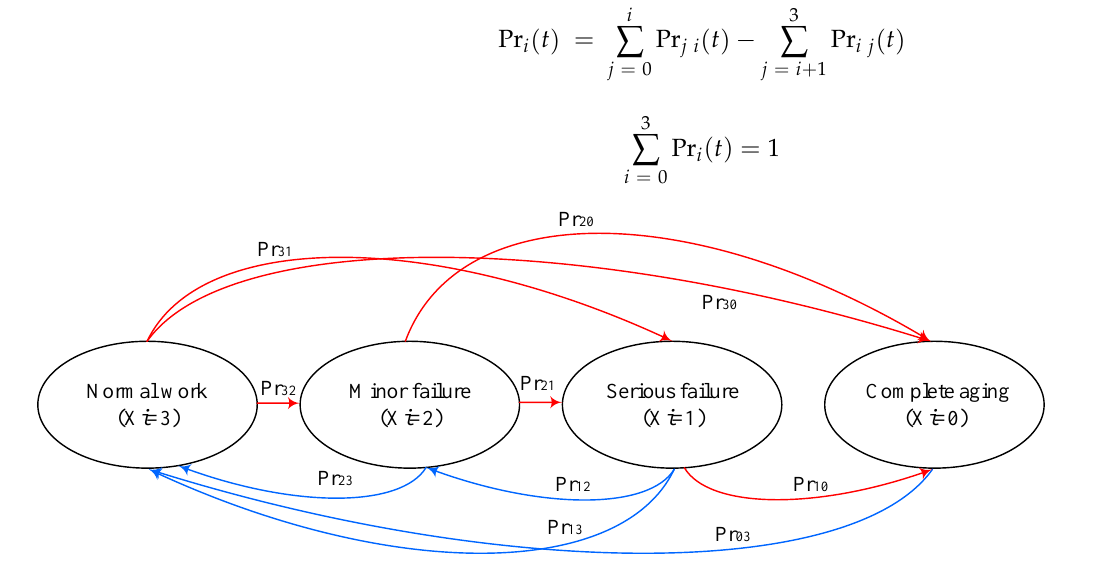
Figure 3. The multistate transition process of a wind turbine system.